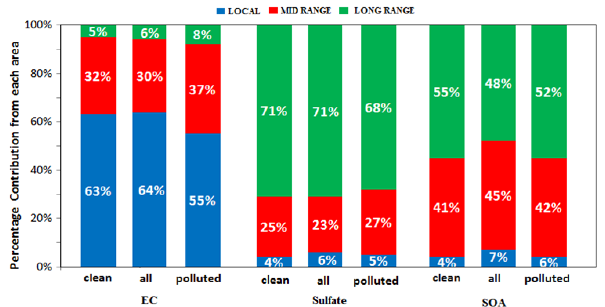
Fig. 3. Percent contributions from each area during high, all, and low particulate matter concentration days for the simulated summer